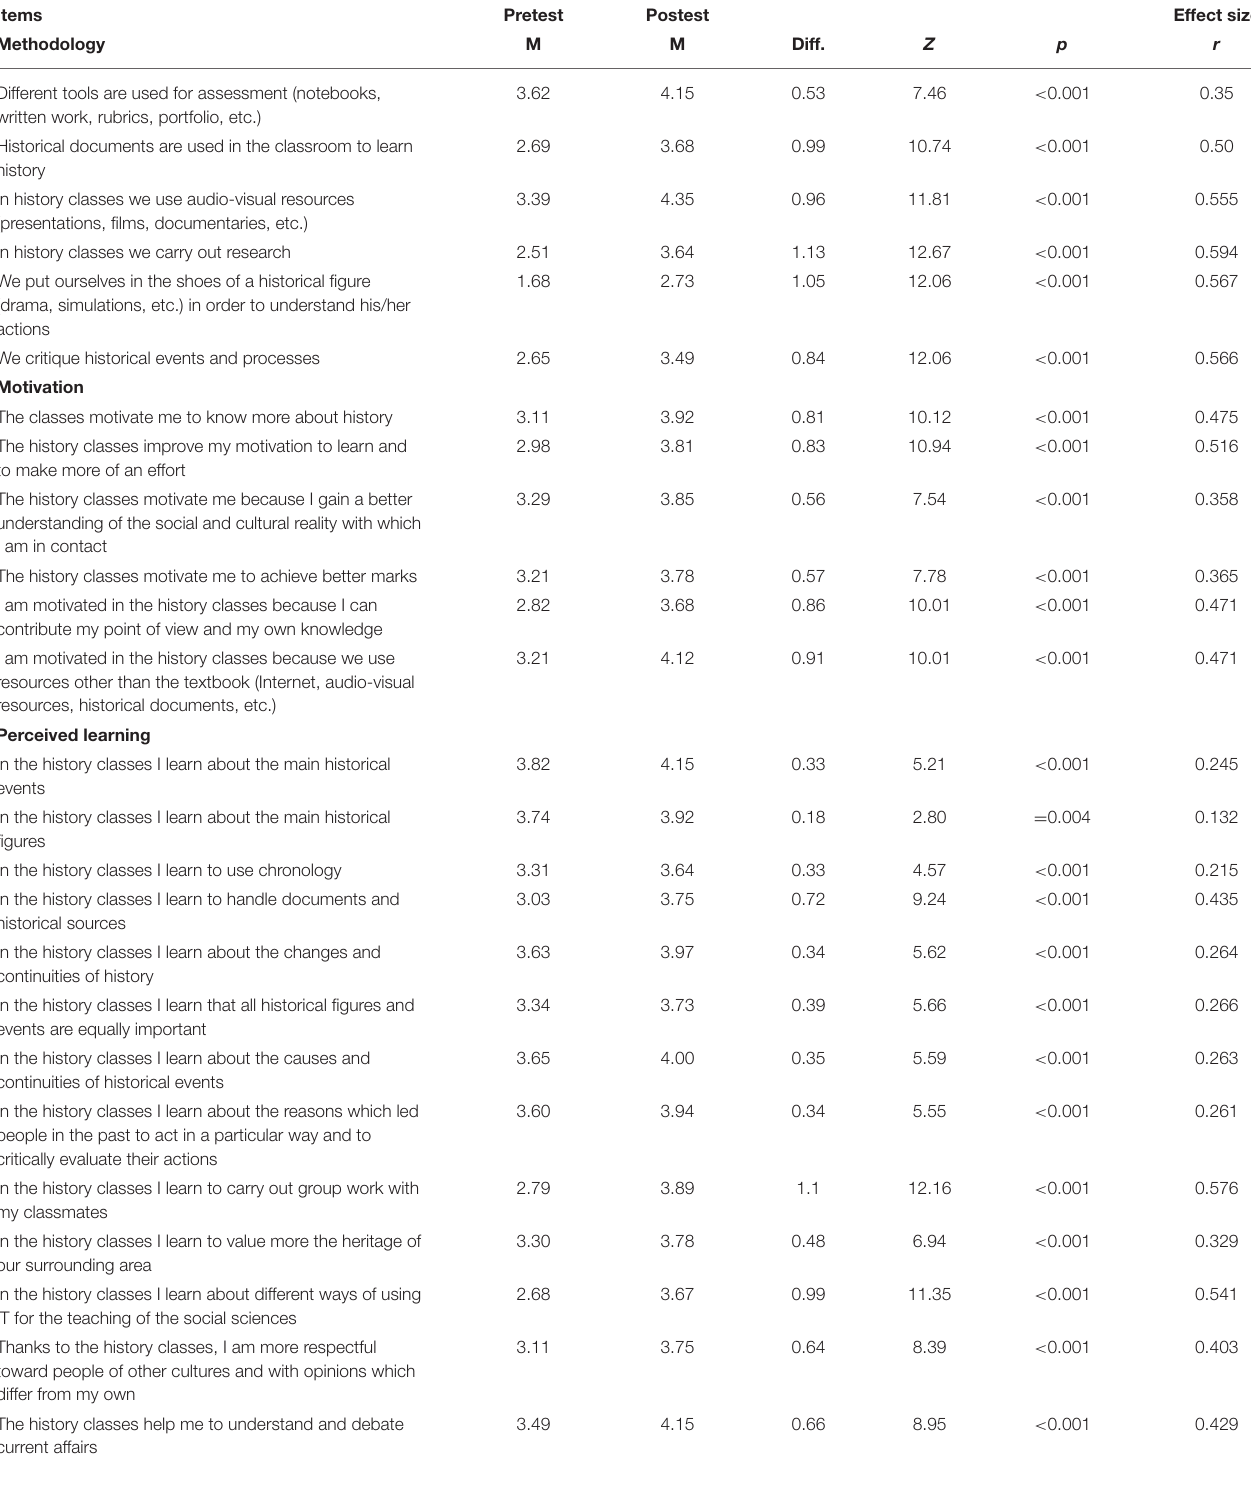
TABLE 7 | Differences of averages between pretest-posttest in the evaluation of methodology. Items Pretest Postest Effect size Methodology M M